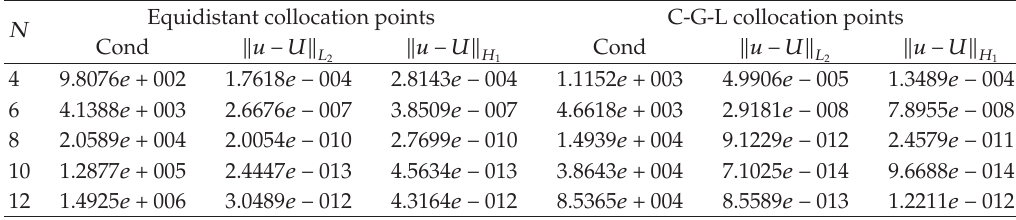
(cid:4) 10, β (cid:4) 100 (cid:6) 1 2